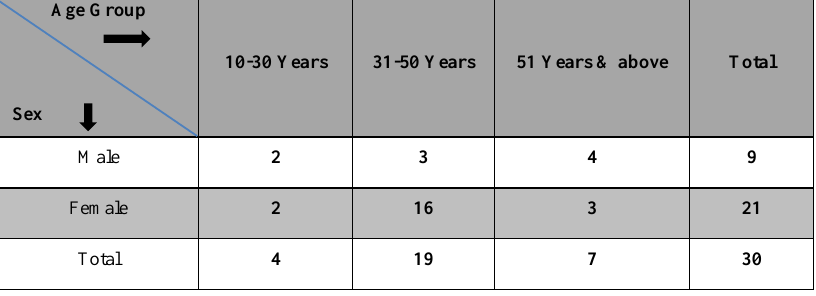
Table 2. Age-group-wise distribution of male and female subjects in study and control groups.